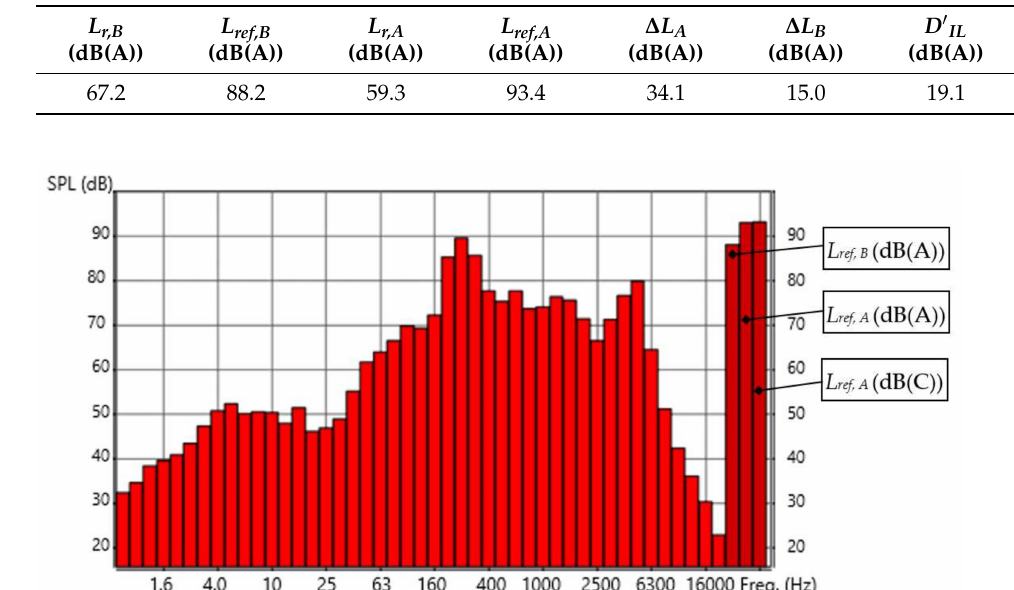
Figure 8. Diagram of sound pressure levels in the range of middle frequencies of the one-third octave bands from 20 Hz to 20 kHz with a barrier at the reference point and the single-number rating of sound insulation at the reference point: without a barrier L ref, B in dB(A), with a barrier L ref, A in dB(A), and with a barrier L ref, A in